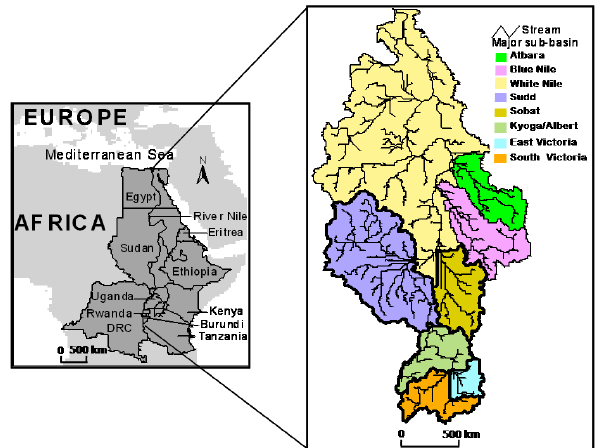
Fig. 1. Location of the River Nile in Africa, the countries in which the River Nile basin takes part, the major streams and major catch- ments of the River